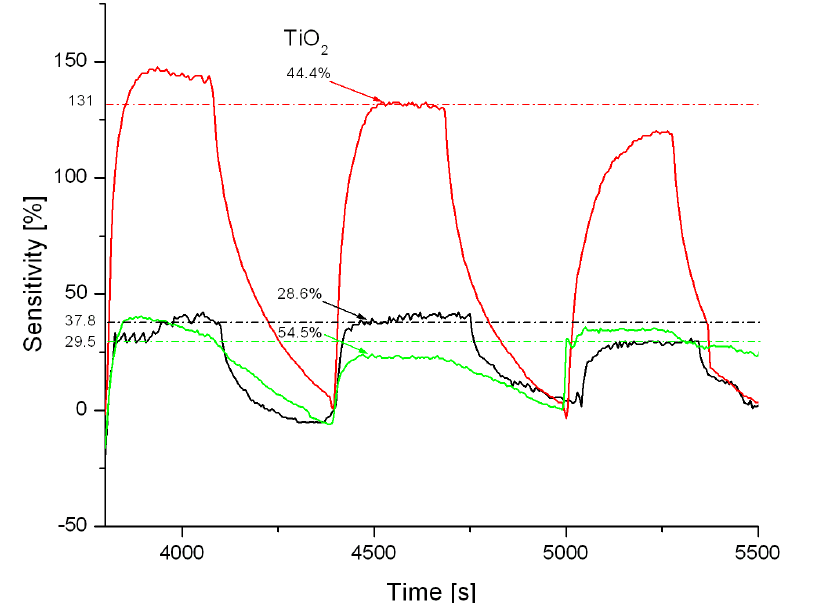
Figure 6. NH sensitivity of TiO 3